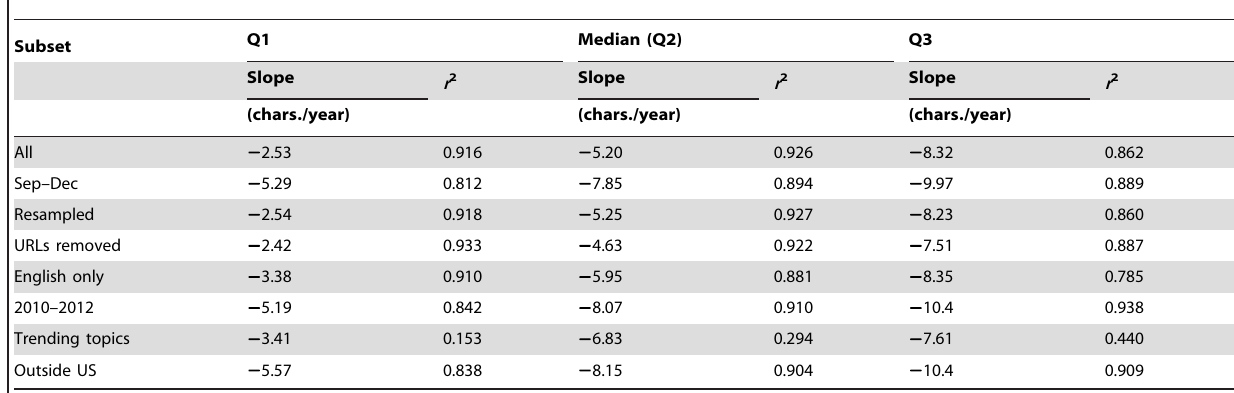
Table 1. Slopes of utterance length quartiles temporal regression lines.